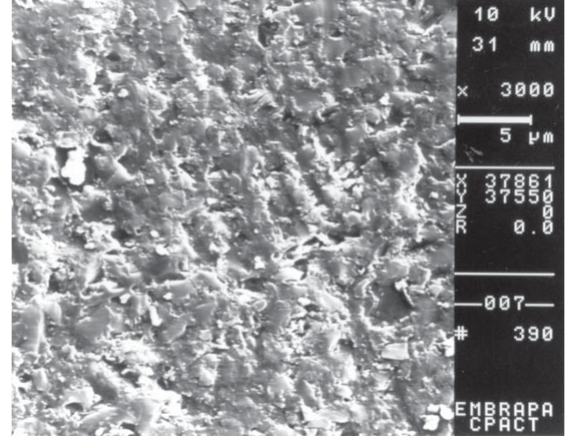
Figure 7. SEM micrography of Filtek Z250 surface at aging time 0 (SEM original magnification 10000 × ).